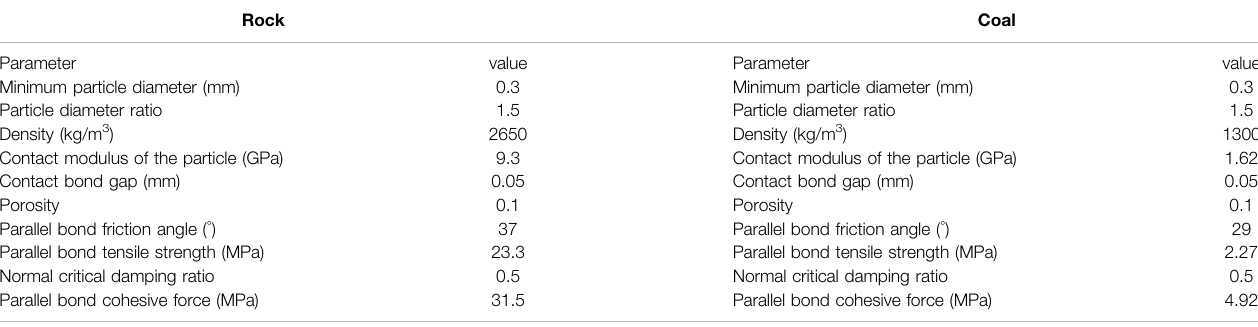
TABLE 2 | Microscopic parameters of rock and coal.